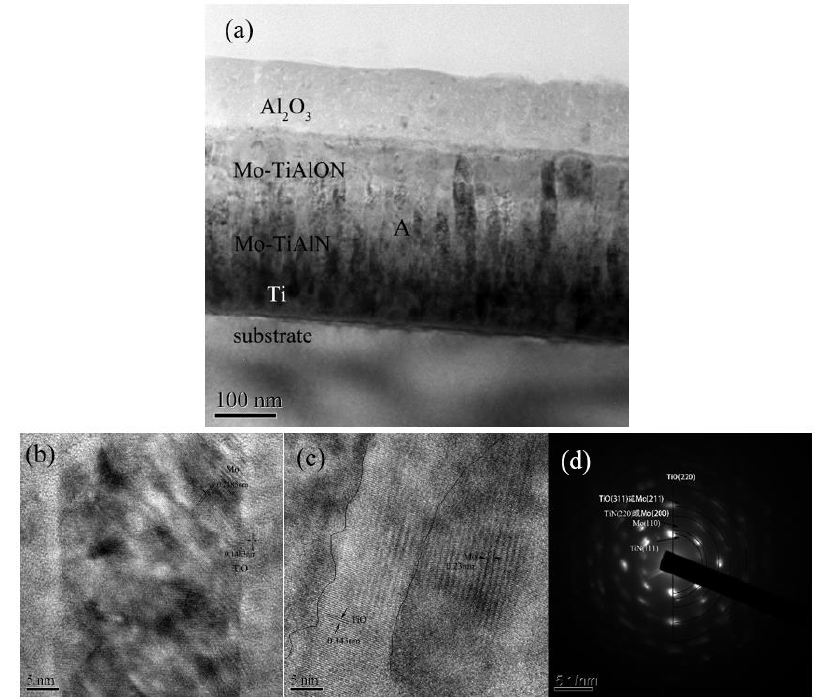
Figure 9. TEM images of TiMoAlON selective absorbing films. ( a ) Cross-sectional microscope, ( b ) HRTEM image of columnar grain, ( c ) HRTEM image of the zone between two neighboring columnar crystals, and ( d ) SAED pattern of zone A.